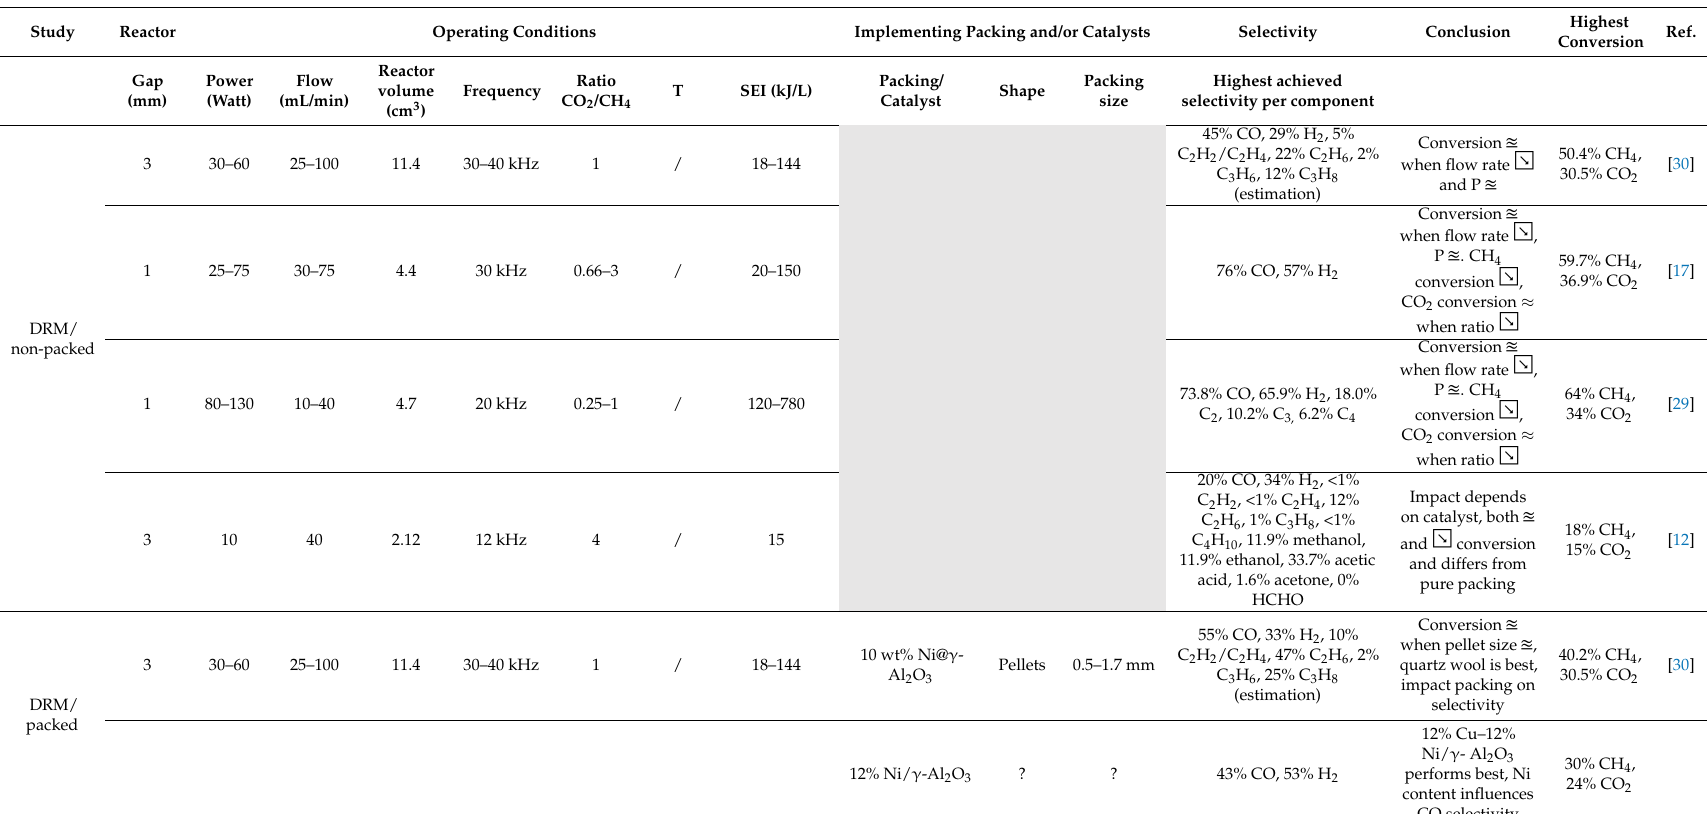
Table 2. Summary of a selection of literature for DRM in a non-packed and a packed DBD reactor. Table 1. Summary of a selection of literature for CO 2 splitting in a non-packed and a packed DBD reactor. Table 1. Summary of a selection of literature for CO 2 splitting in a non-packed and a packed DBD reactor. Table 1. Summary of a selection of literature for CO 2 splitting in a non-packed and a packed DBD reactor. Table 1. Summary of a selection of literature for CO 2 splitting in a non-packed and a packed DBD reactor. Table 1. Summary of a selection of literature for CO 2 splitting in a non-packed and a packed DBD reactor. Table 1. Summary of a selection of literature for CO 2 splitting in a non-packed and a packed DBD reactor. Table 1. Summary of a selection of literature for CO 2 splitting in a non-packed and a packed DBD reactor.